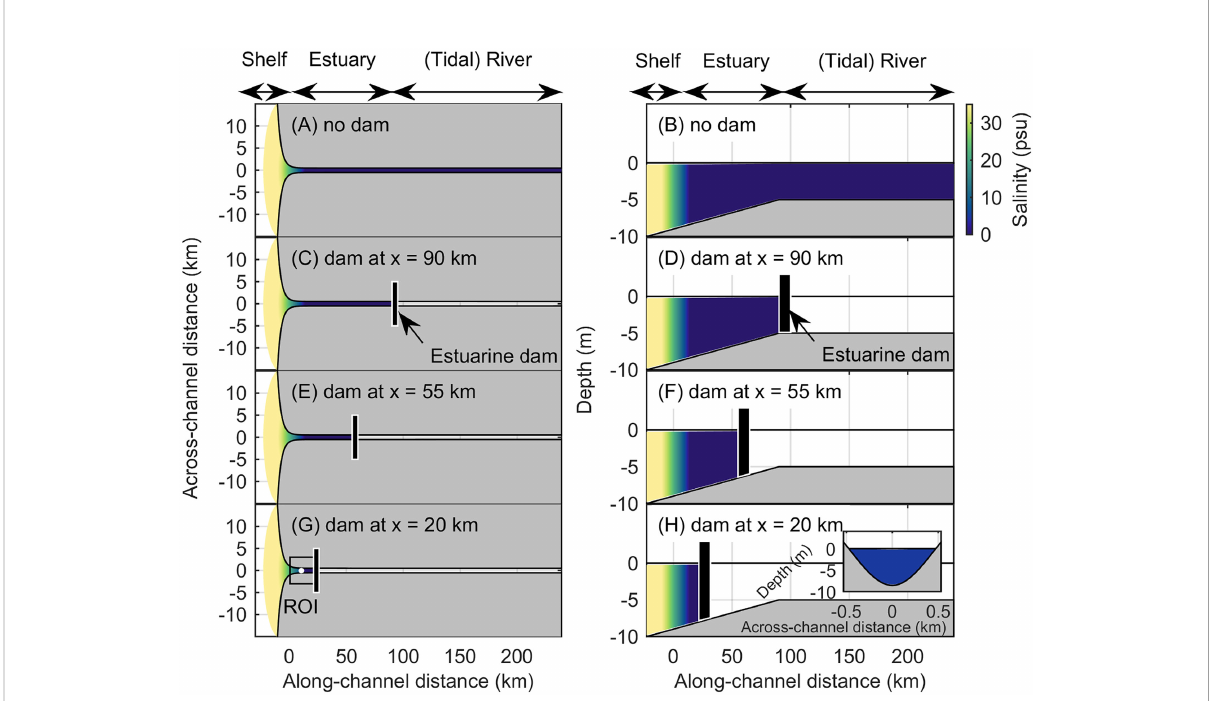
FIGURE 2 Model domain for (A, B) no dam, (C, D) dam at x = 90 km, (E, F) dam at x = 55 km, and (G, H) dam at x = 20 km scenarios. Left plots are top- view, right plots are side-view. Salinity and bathymetry are the model initial conditions. An example of a region of interest (ROI) for a post-dam estuary shown in (G) . Point is the ROI center and is the location of the across-channel transect shown as an inset in (H) and the Figure 6 time